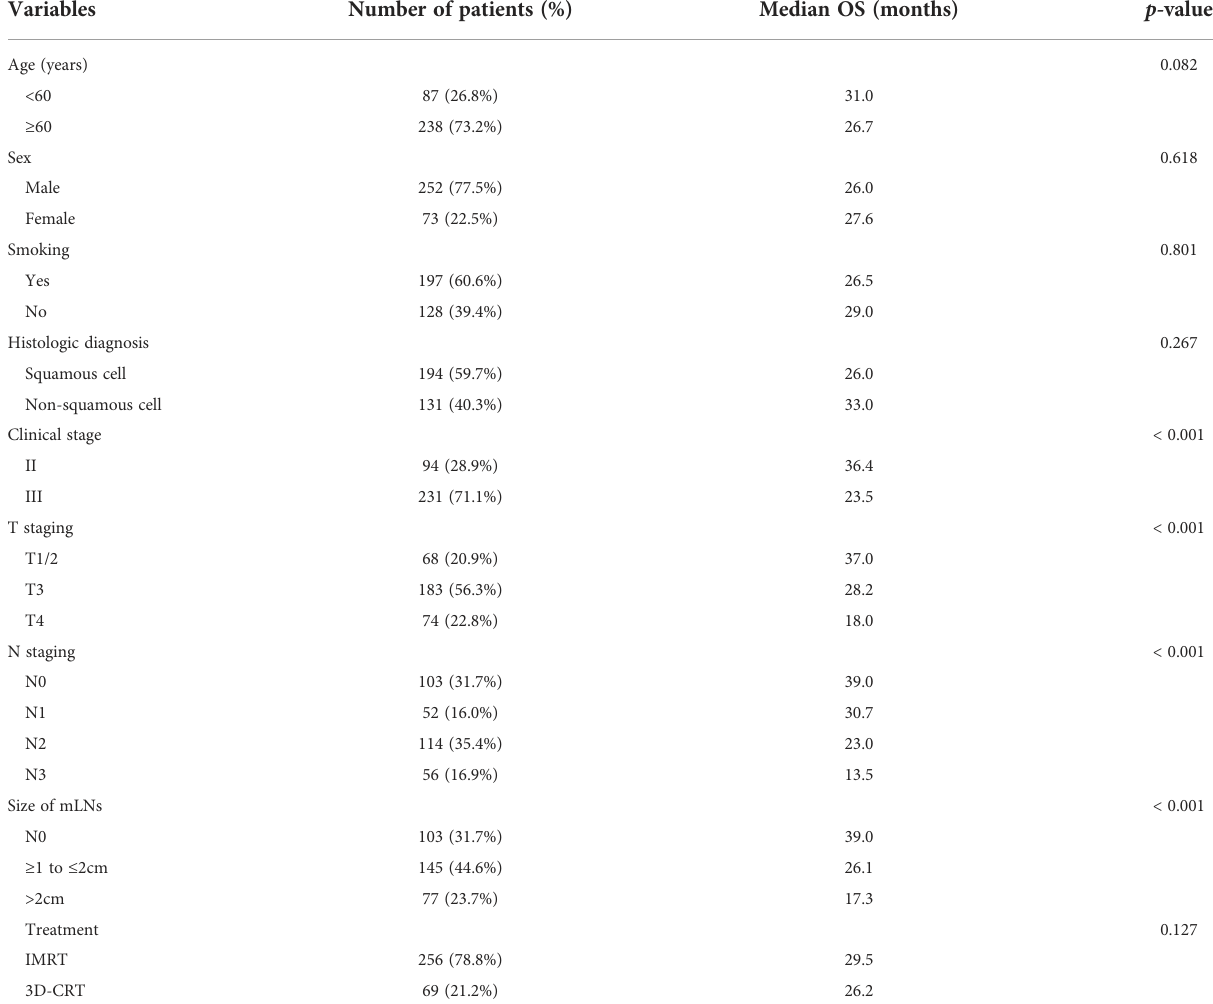
TABLE 1 Patient characteristics and univariate analysis of prognostic